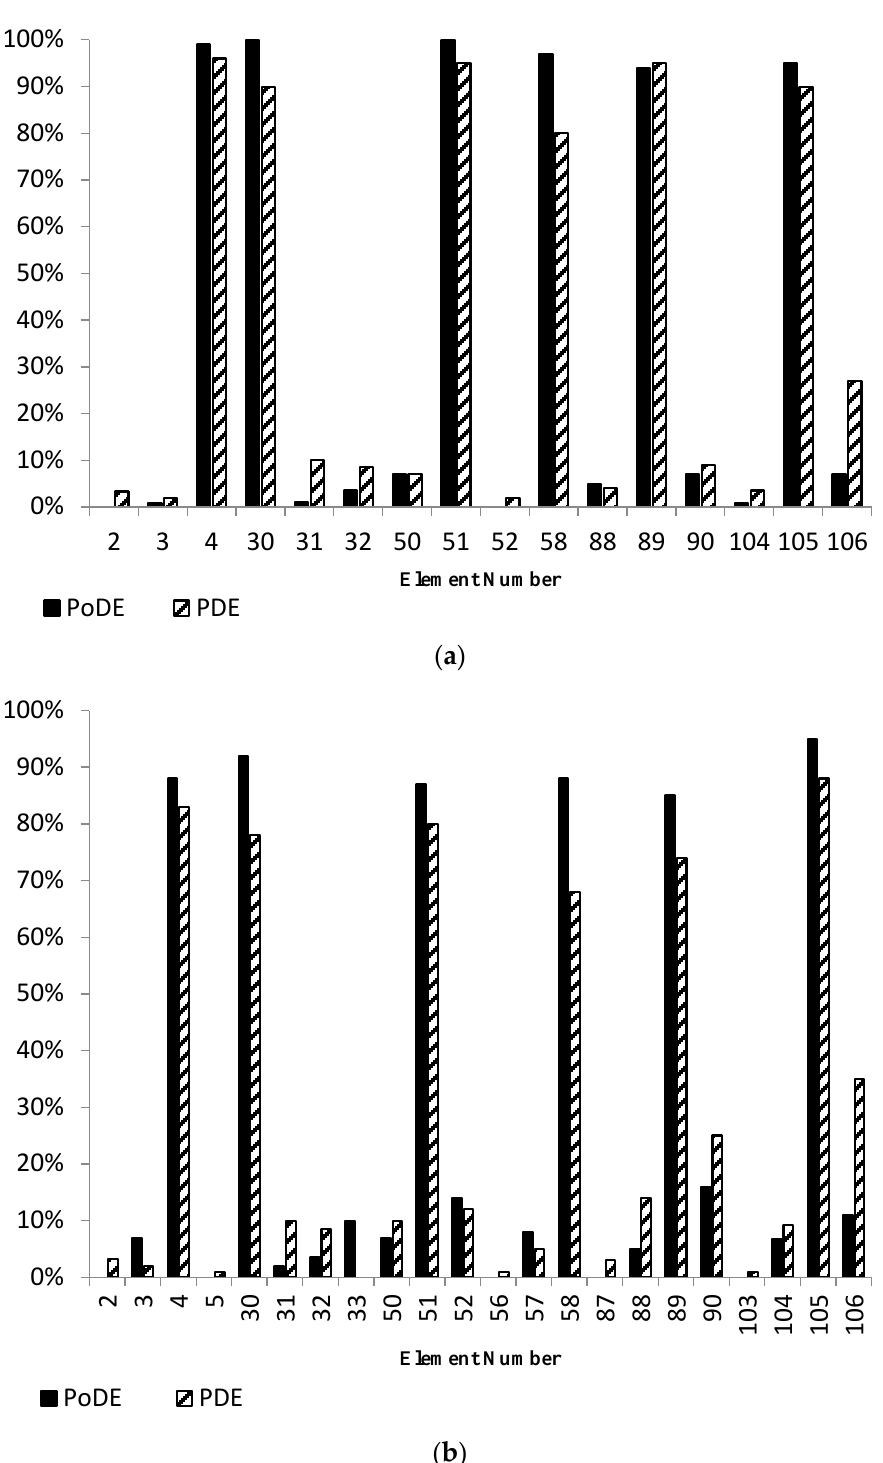
Figure 7. Probability of damage existence for damage case 2 of the dome truss. ( a ) Probability of damage existence with noise level 5%. ( b ) Probability of damage existence with noise level of 10%. Table 8. PoDE for damage case 1 of the dome truss.